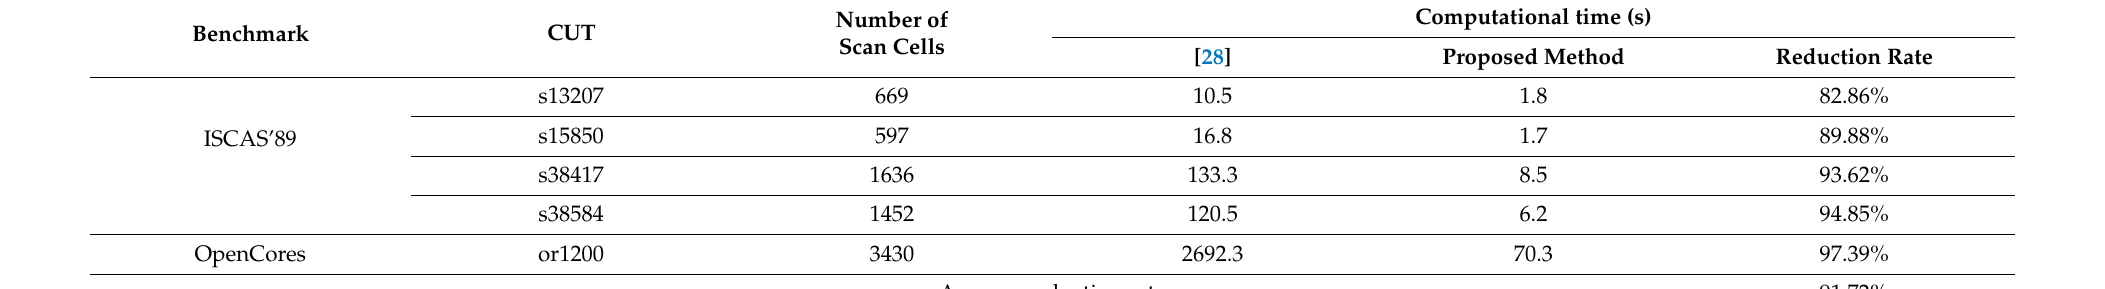
Table 4. Comparison of computational time with the previous